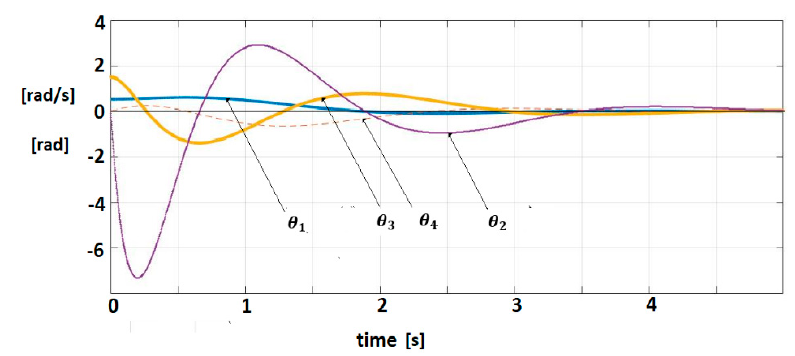
Figure 6. Polar plot of 𝑐 (cid:3021) ((𝑗𝜔𝐼 − 𝐴 (cid:2869) ) (cid:2879)(cid:2869) 𝑏.